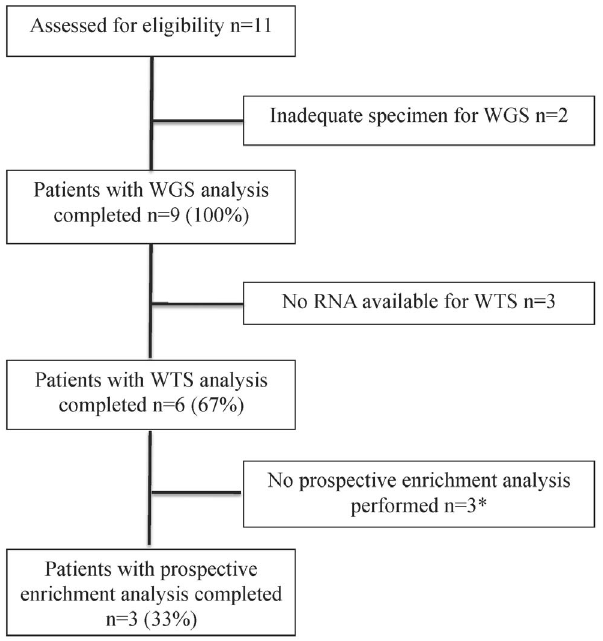
Figure 1. CONSORT schematic on patient enrollment. *-Prospective enrichment analysis was performed prior to discussing the results with the patient and treating oncologist for the last three patients